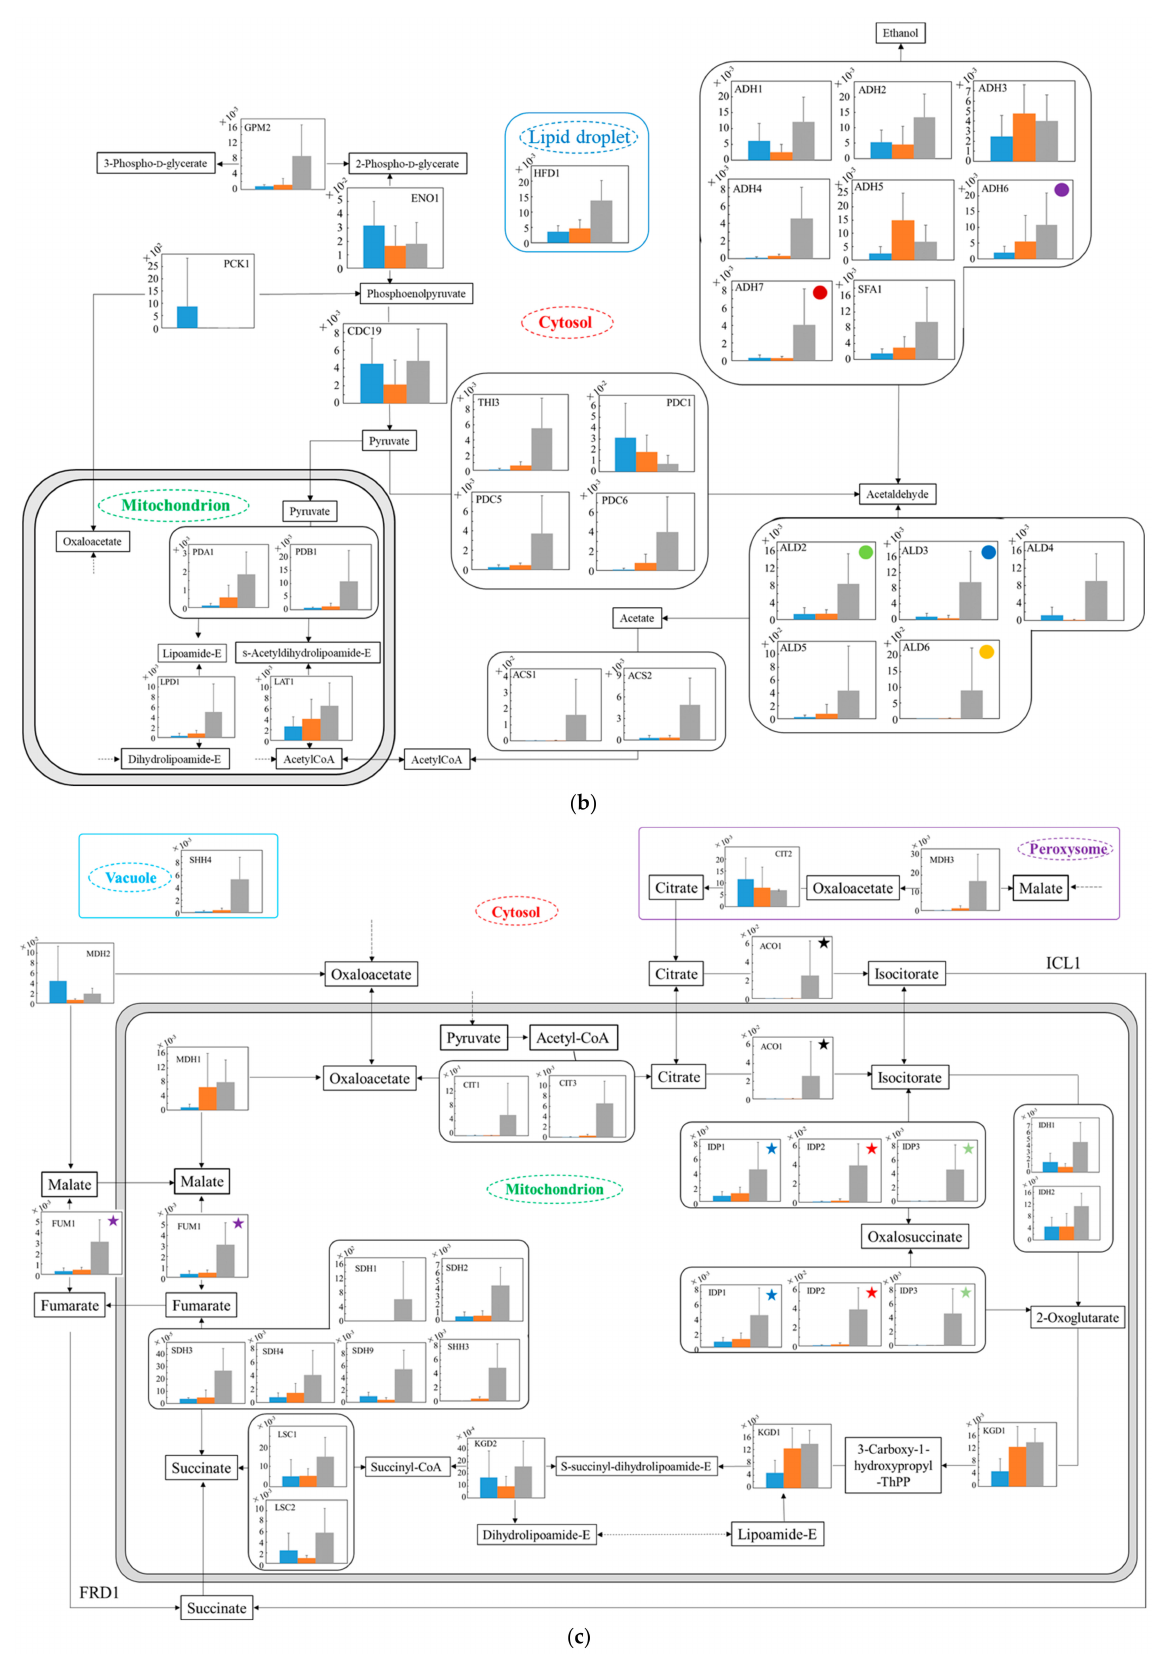
Figure 6. Relative quantification of mRNA of wildtype and no.7 in SD and in SD/YNBG under anaerobic conditions. Shown data are the relative mRNA levels normalized by level of RDN18 as